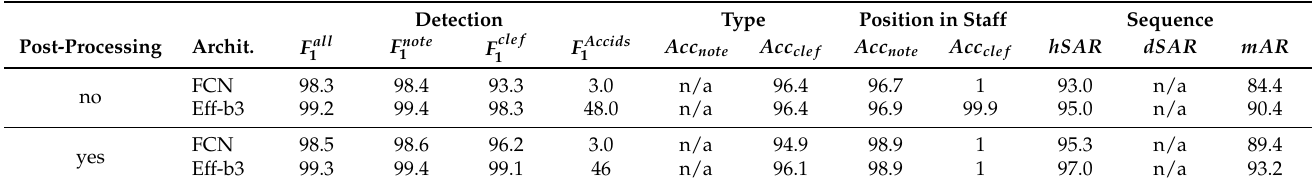
Table 7. Mixed model experiments on the Pa904 dataset with and without post-processing; that is, no training data for fine-tuning were used. Only the model of Table 4 was used for predictions and evaluated solely on the Pa904 dataset (all metrics in %). The recognition rate of the accidents is very low, especially with the FCN, since this was already low in the “mixed model” due to the low amount of training instances.